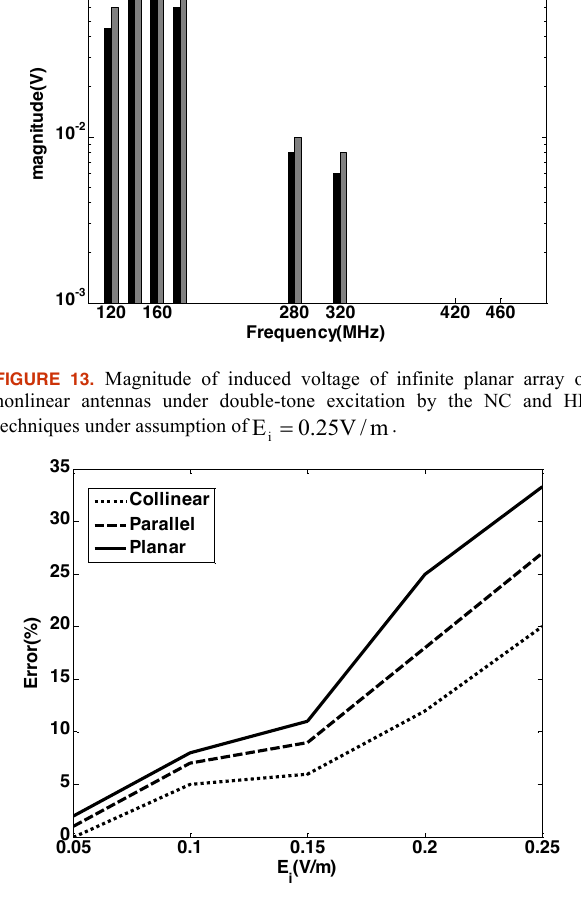
FIGURE 14. Maximum value of the relative error of the approximate method versus E i for parallel, collinear and planar infinite arrays.